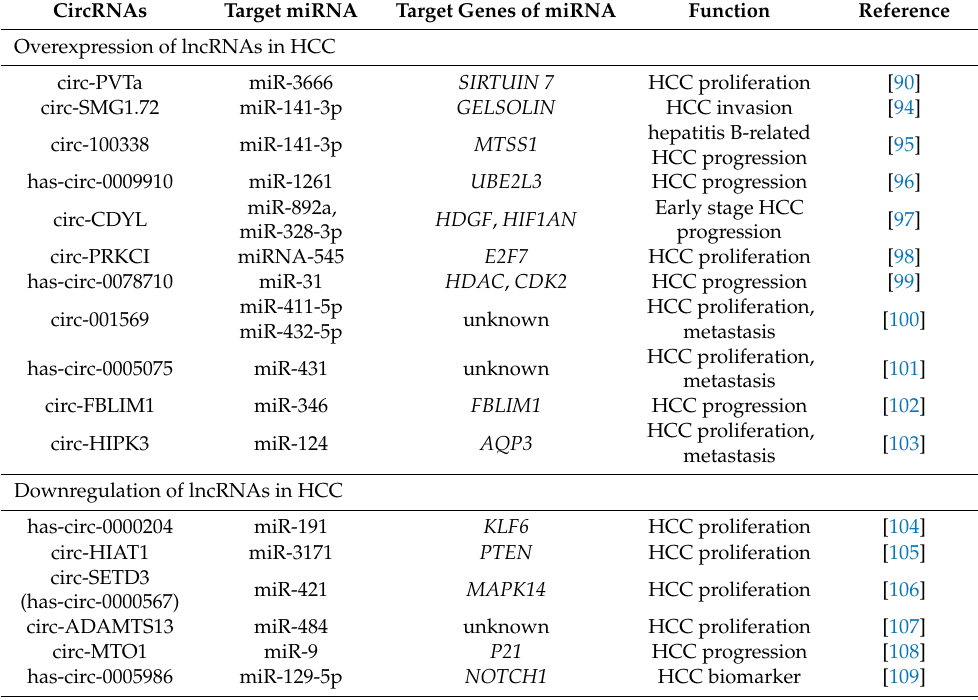
Table 2. Circular RNA and microRNA networks in